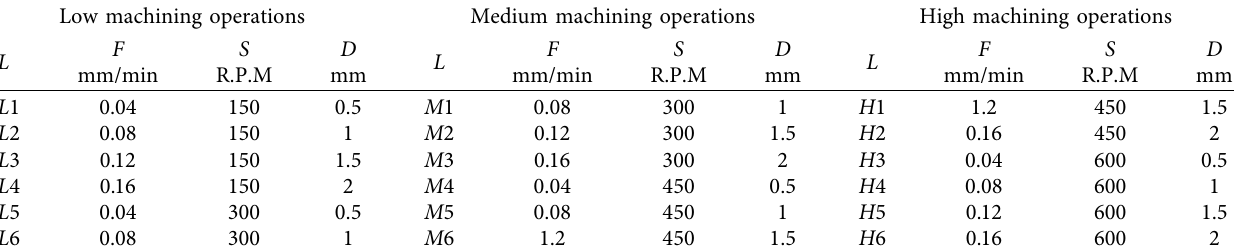
Table 7: Experimental turning parameters at different machining